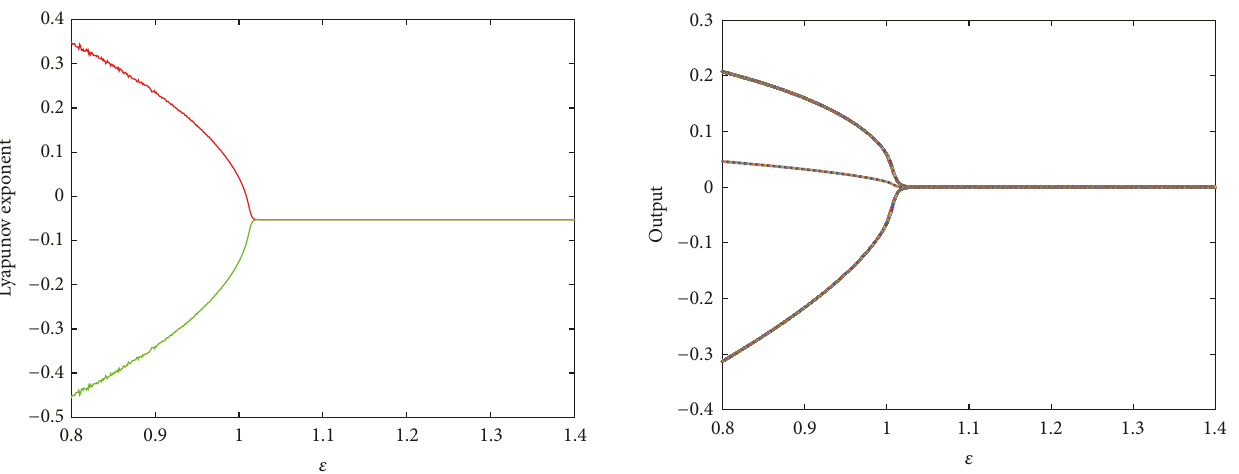
Figure 4: The change of Lyapunov indexes with 𝜀 . Figure 5: The bifurcation of the output with the change of 𝜀